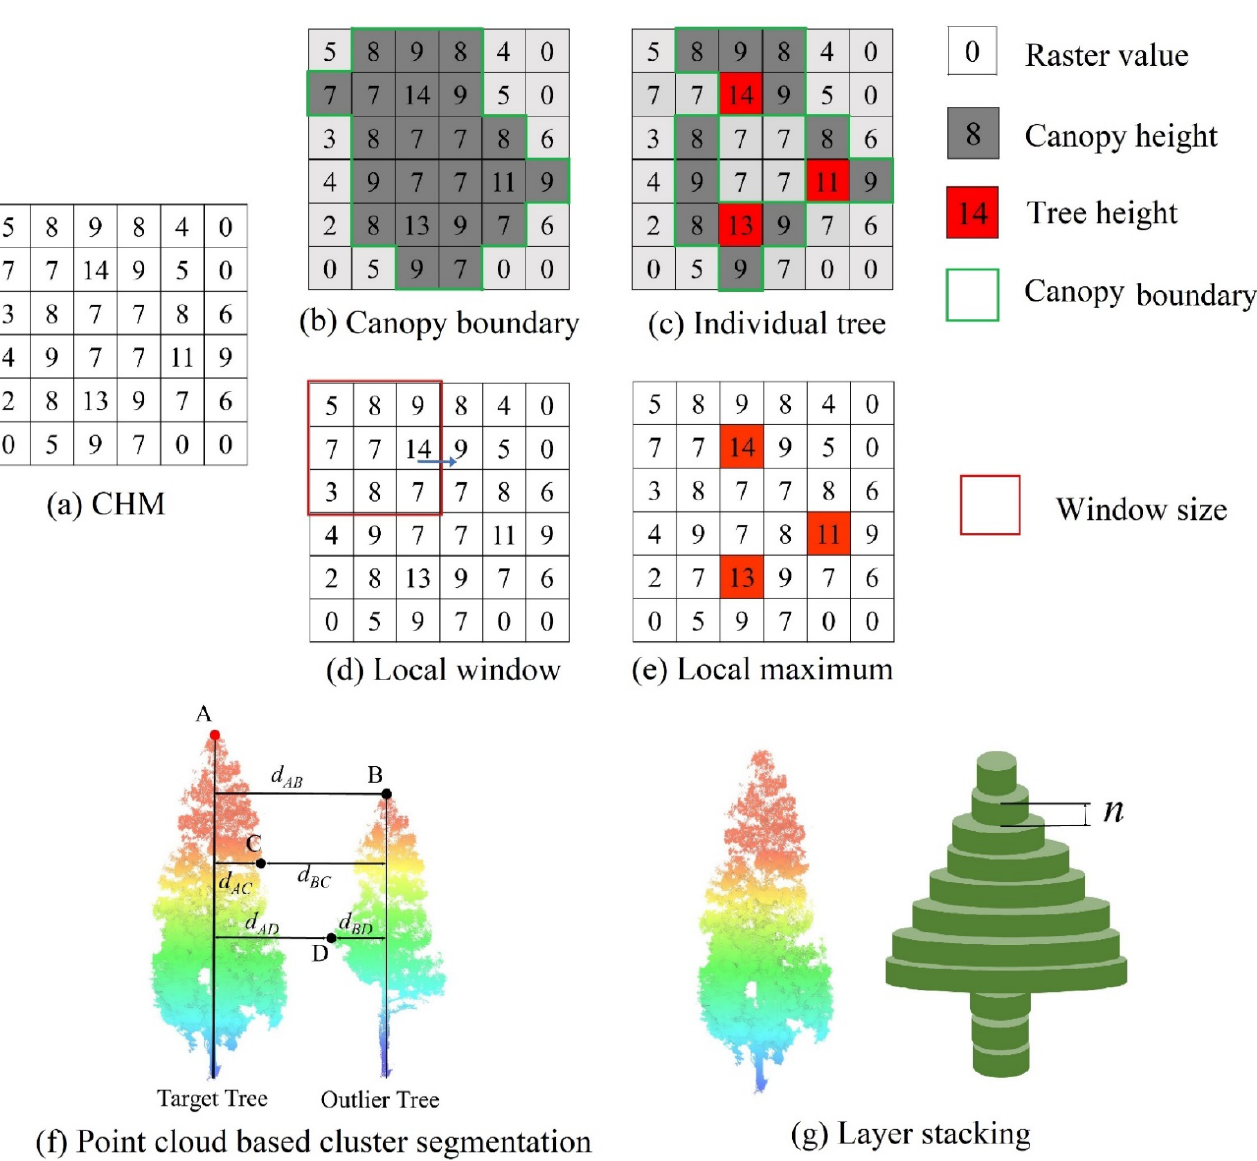
Figure 2. A schematic diagram of four individual tree segmentation methods. ( a ) represents the CHM; ( b , c ) represent WAs; ( d , e ) represent the LM; ( f ) represents PCS; and ( g ) represents the LS algorithm.